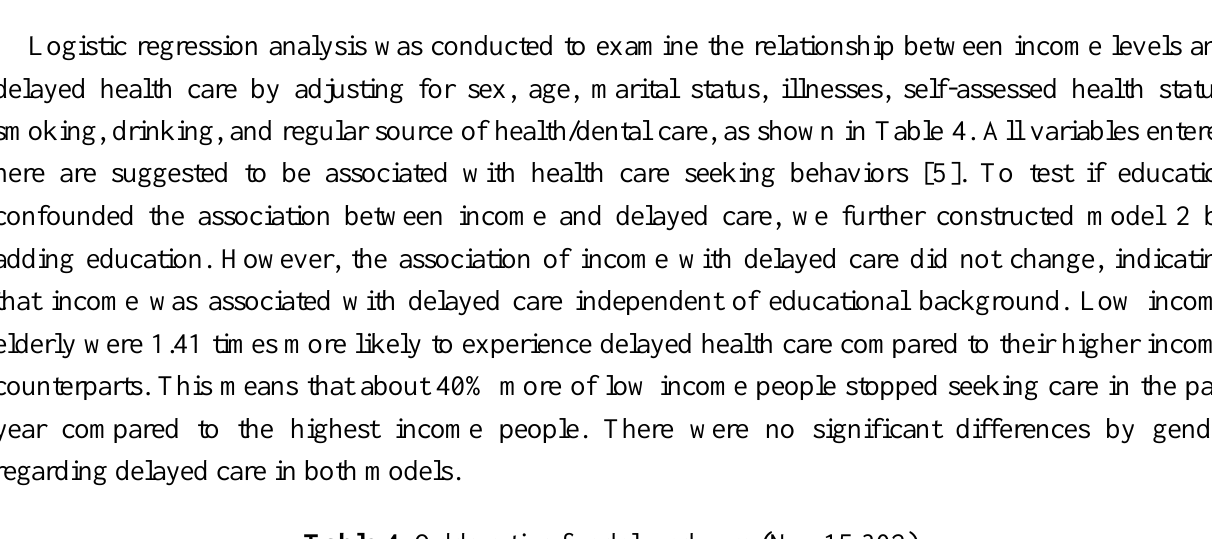
Table 4. Odds ratios for delayed care (N =